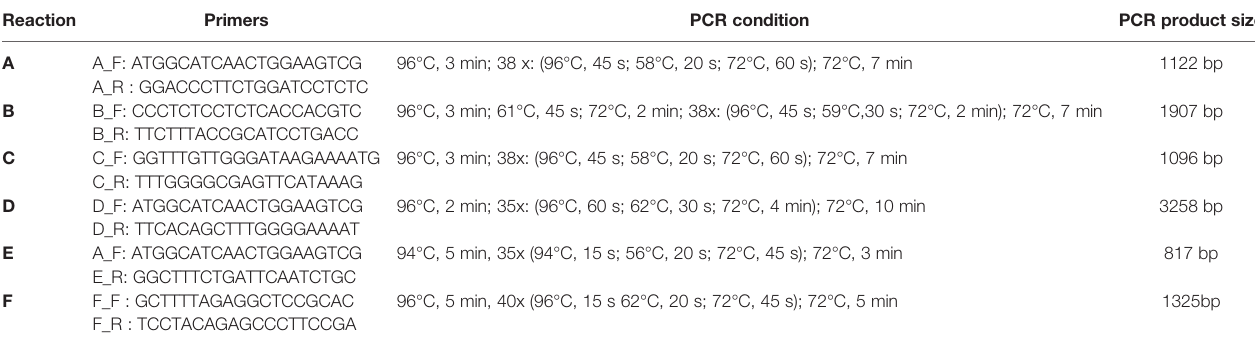
TABLE 2 | Primers and PCR conditions used for the FCN2 gene 3 ’ UTR